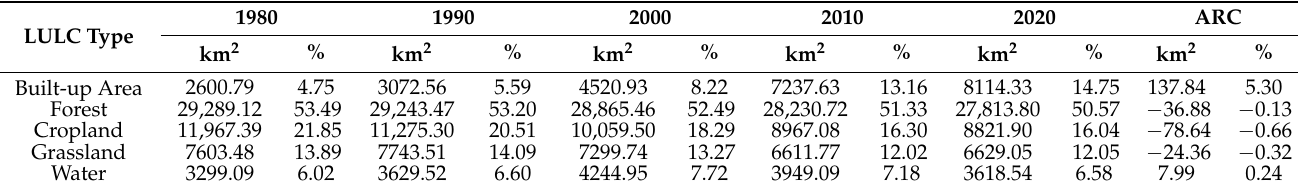
4 show the spatiotemporal area and percentage change in all LULC categories. Cropland,